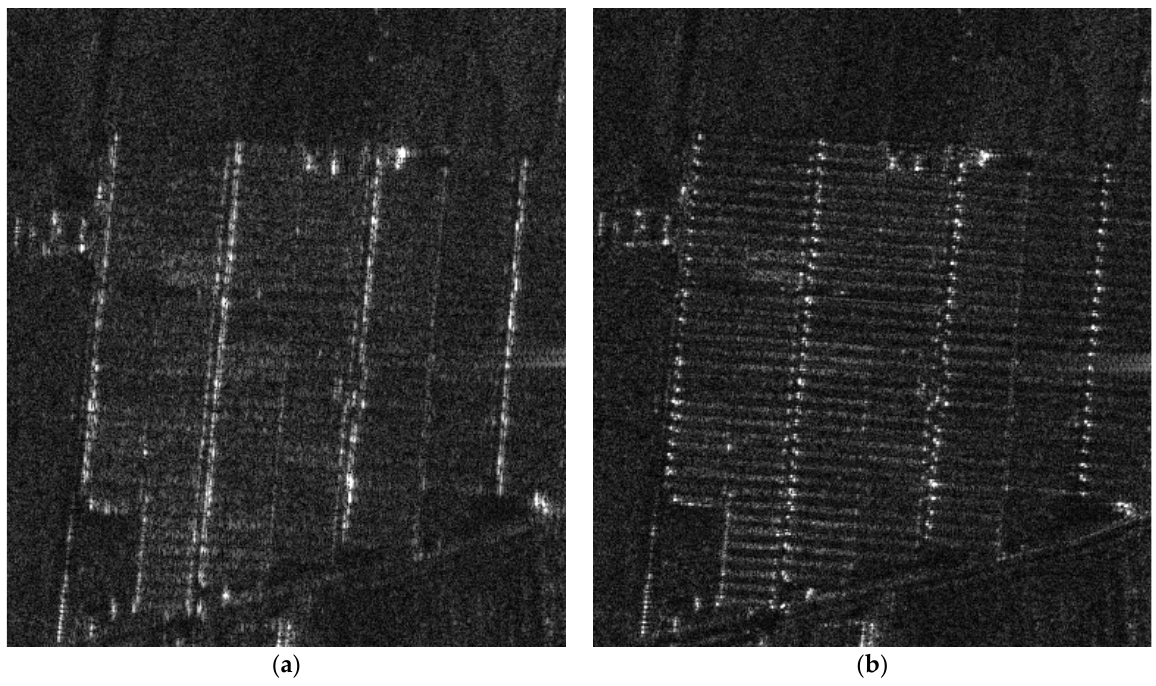
Figure 12. The enlarged views of Area 1 and Area 2 in Figure 11. ( a ) The enlarged view of Area 1; ( b ) The enlarged view of Area 2.